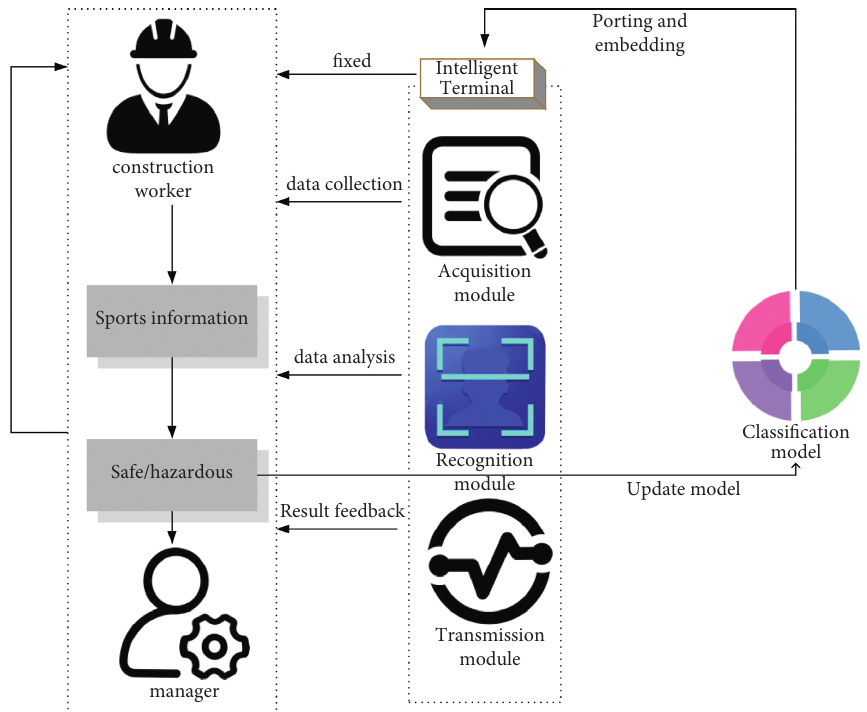
Figure 3: Civil engineering safety management intelligent identification system. Table 1: Feature extraction type and serial number